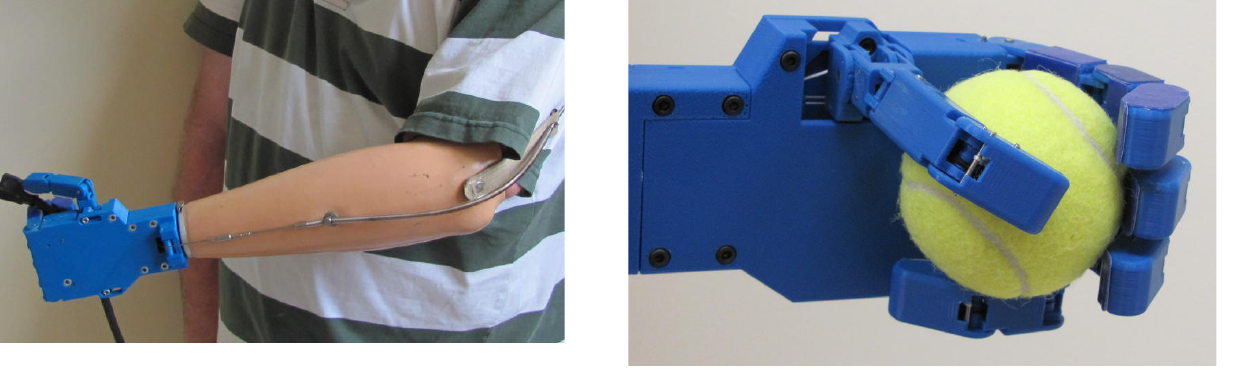
Figure 10. The prosthetic hand and forearm used by an amputee, grasping a plug.